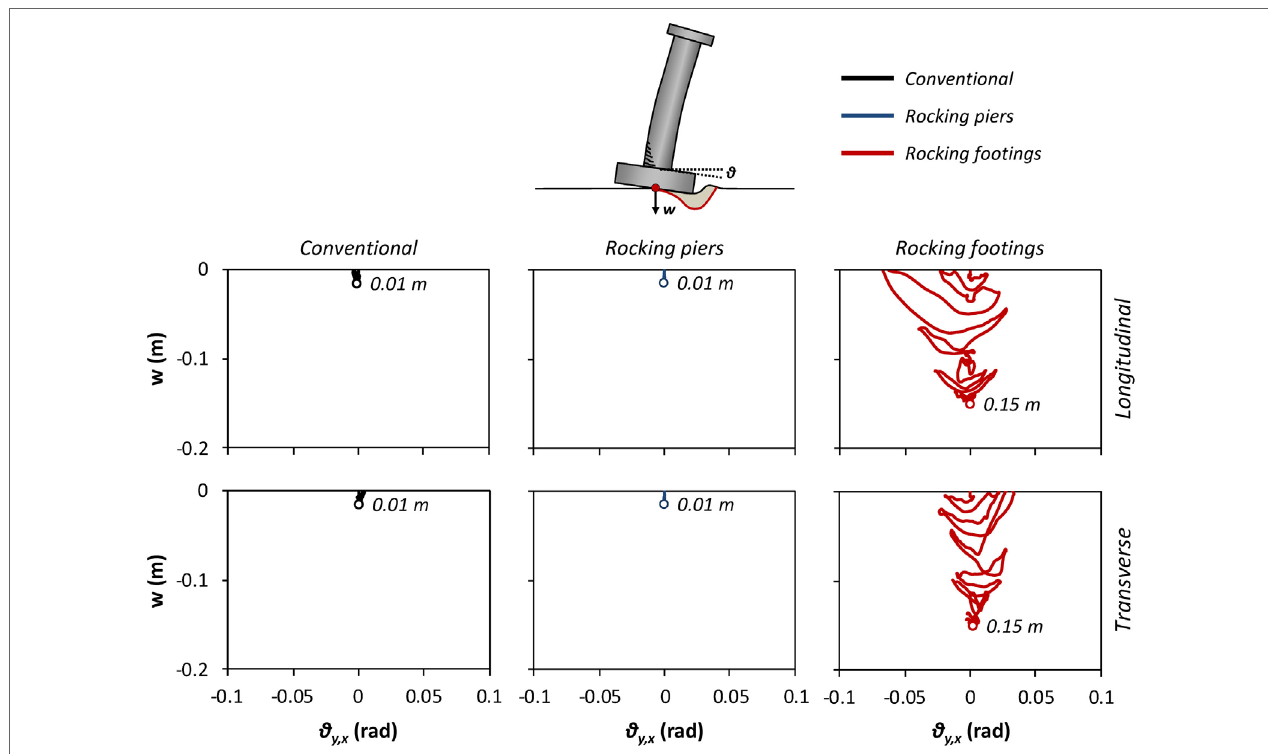
FigUre 13 | Comparison of the three design alternatives in terms of settlement–rotation ( w – θ ) response at each direction, indicatively for pier P4 of the bridge for the Takatori